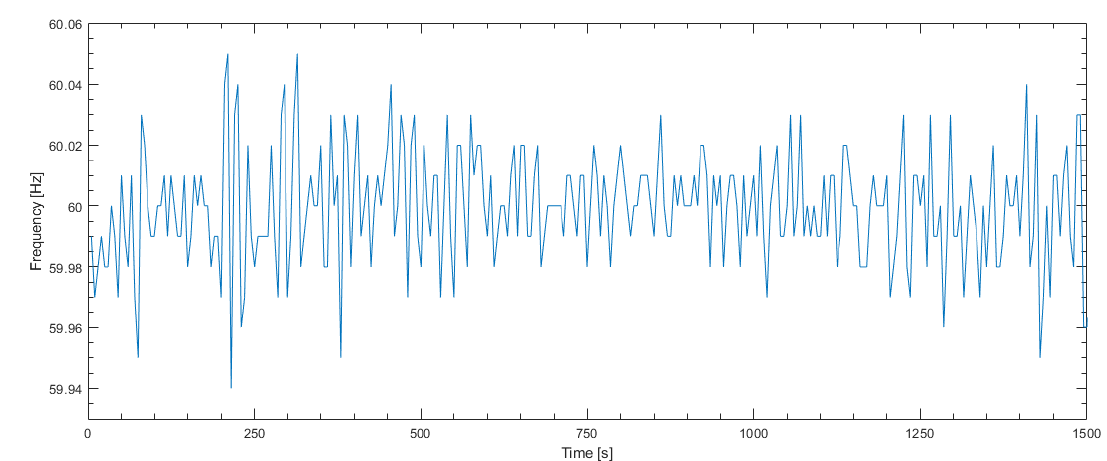
Figure 16. Frequency in the Microgrid in Island